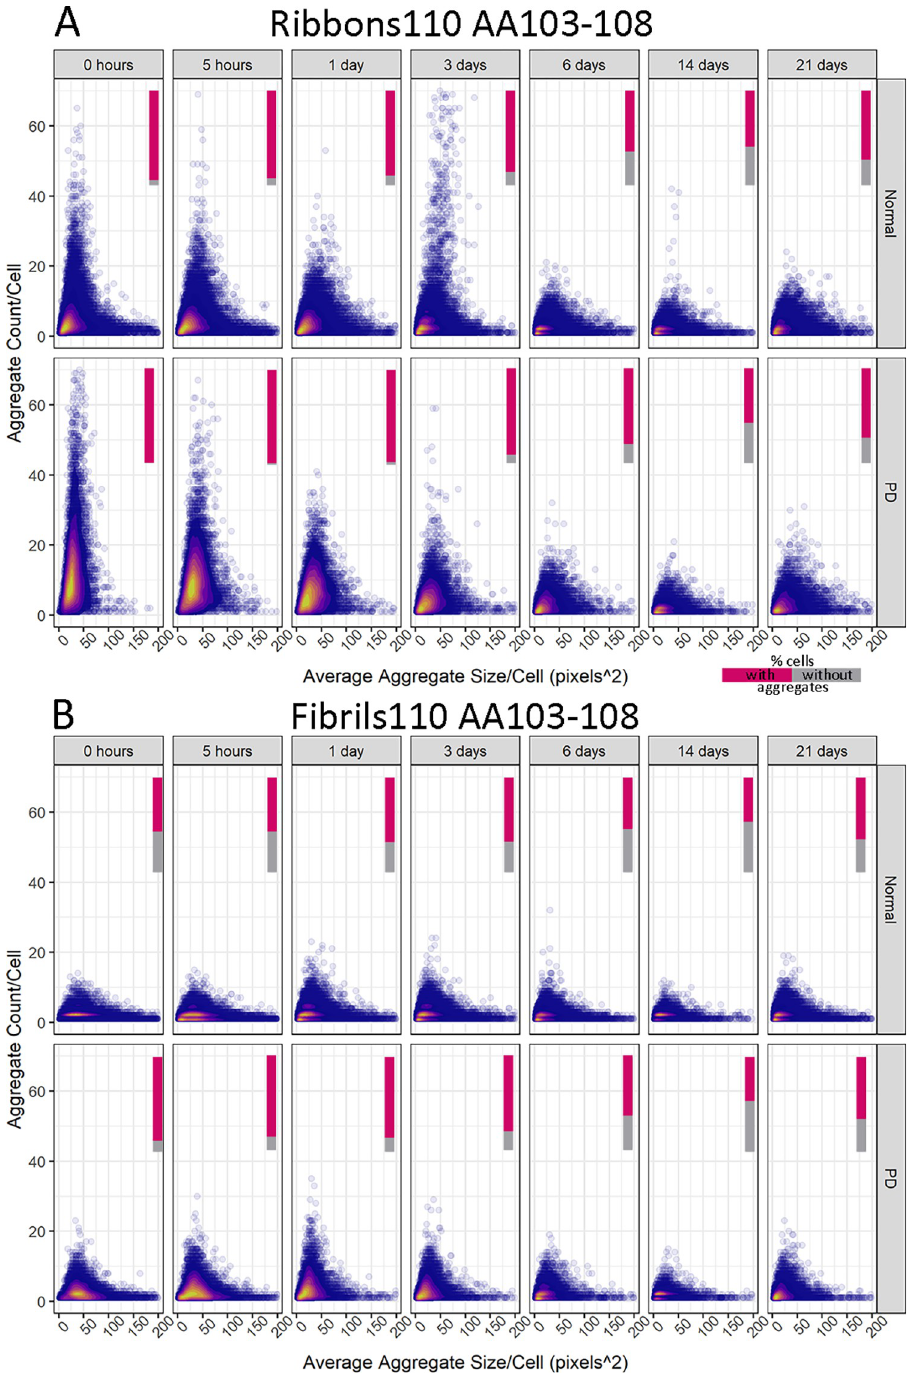
Fig 5. Density plots showing a differential response to α -syn aggregates for control and PD-derived pericytes based on AA103-108 for Ribbons and fibrils 110. Cells without aggregates are excluded from density plots. Relative amounts of cells with aggregates are represented in a bar (% cells with aggregates in magenta, % cells without aggregates in grey).